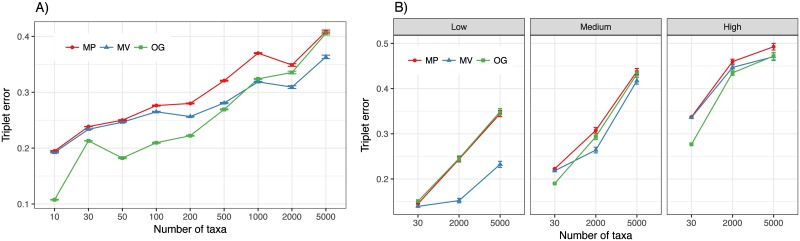
Absolute triplet distance as a function of the number of taxa.A: Results from D1, D2, and D3 are combined in one figure; 30 on the x-axis corresponds to D1, 2000 and 5000 to D2, and the remaining cases to D3. For D1 and D2, we fixed R/C = 1 and the clock divergence parameter to medium to best match the conditions of D3. B: Results for D1 and D2 with R/C = 1 and difference levels of clock divergence.